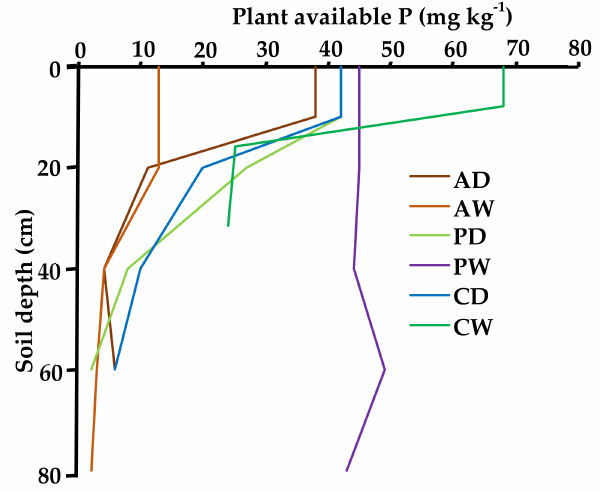
Figure 1. Content of plant available P in the di ff erent management and peatland types extracted by double lactate. Standard error of the mean: 12 mg P kg − 1 . AD: drained forest peatland, AW: rewetted forest peatland, PD: drained percolation mire, PW: rewetted percolation mire, CD: drained coastal influenced peatland, CW: rewetted coastal influenced